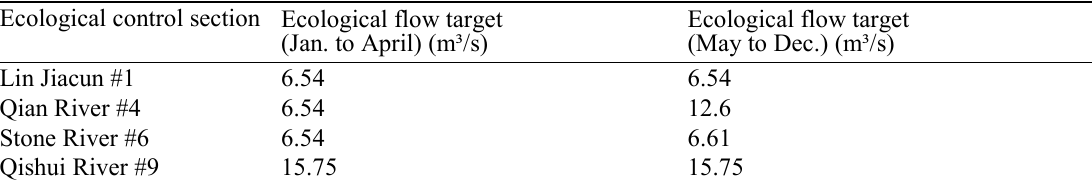
Table 2 Control sections and the minimal eco-flow.